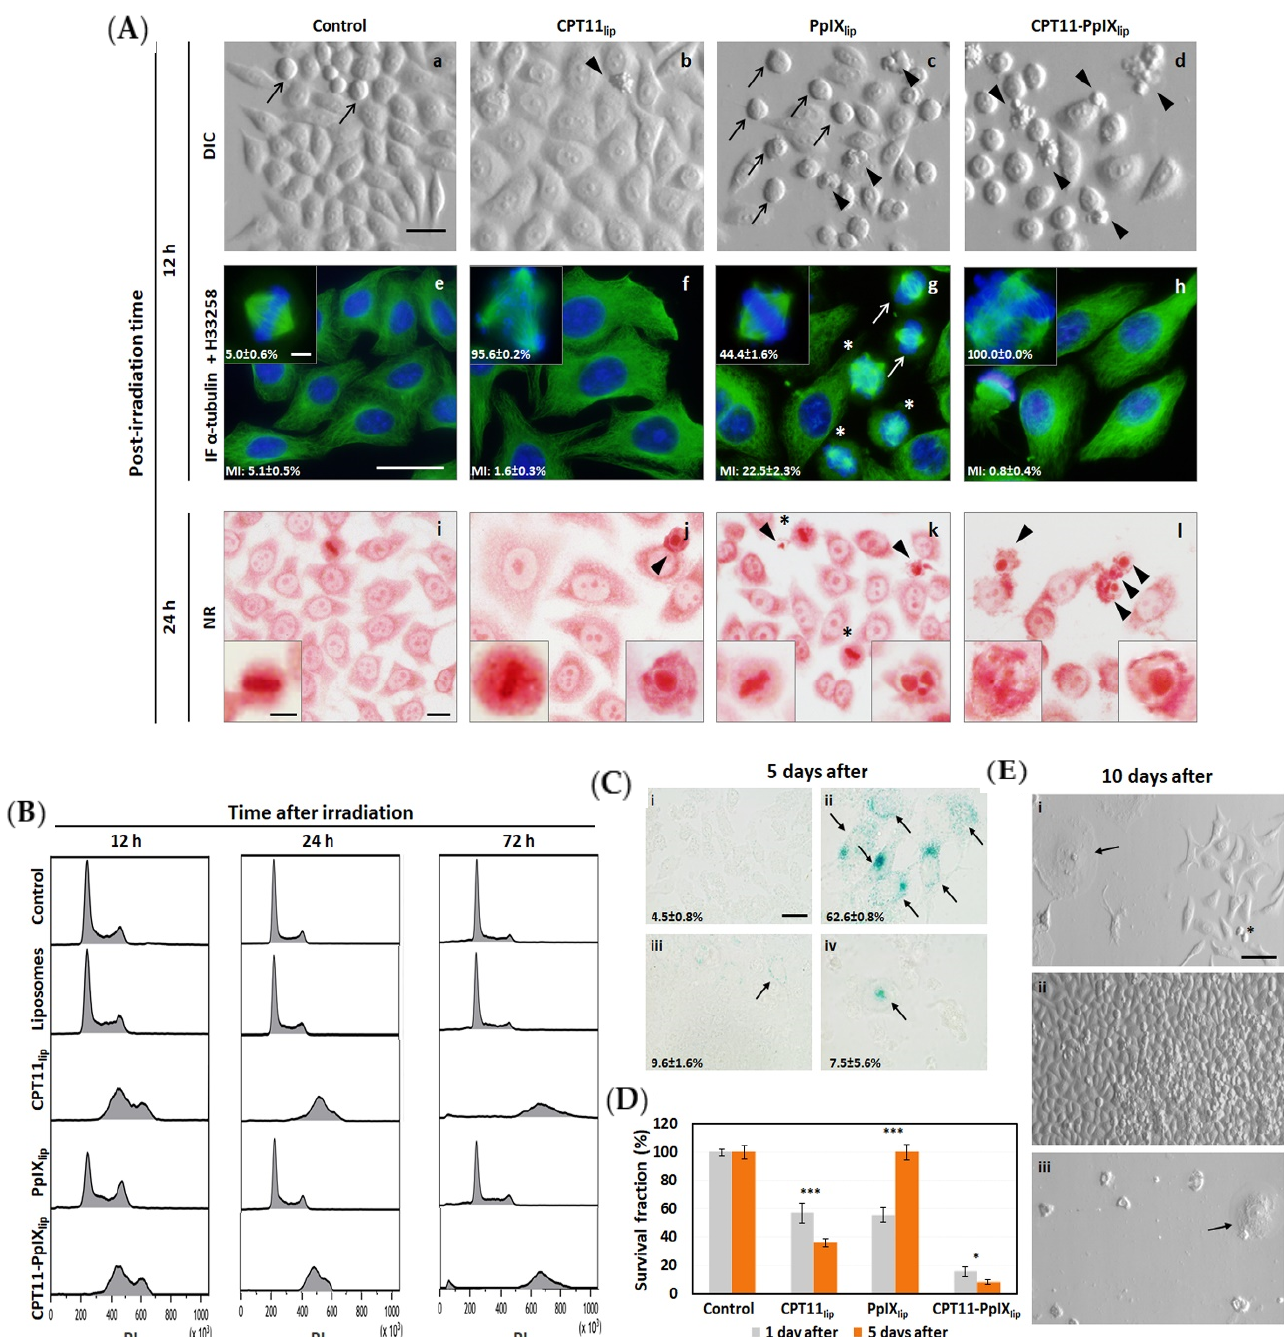
Figure 2. HeLa cell responses at different post-treatment times. ( A ) TOP ( a – d ): Treated and non-fixed cells visualized under differential interference contrast (DIC) microscopy after 12 h. MIDDLE ( e – h ): Indirect immunofluorescence (IF) for α-tubulin of microtubules (green) and H-33258 counterstaining of DNA (blue) in control or treated cells fixed 12 h after irradiation; the numbers refer to the Mitotic Index (MI) and aberrant mitosis percentage in the same samples. BOTTOM ( i – l ): Treated cells were fixed 24 h after irradiation and stained with neutral red (NR). Arrowheads show apoptotic morpholo- gies, arrows mark mitosis and asterisks indicate aberrant mitosis. Bar scale: 25 µ m and 5 µ m in magnifications in all panels. ( B ) Cell cycle analyzed by flow cytometry revealed by propidium iodide (PI) in photodynamic treated cells at 12, 24, and 72 h after irradiation. ( C ) Effect of photodynamic treatment on HeLa cells five days after irradiation. Analysis of senescent cells by